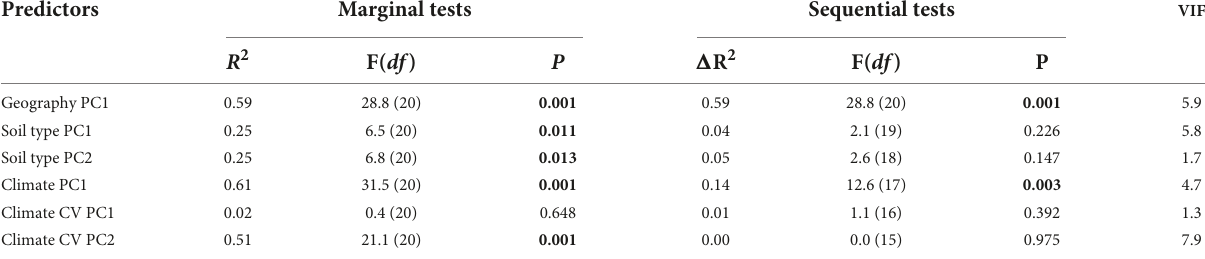
TABLE 2 The results of dbRDA on allele length